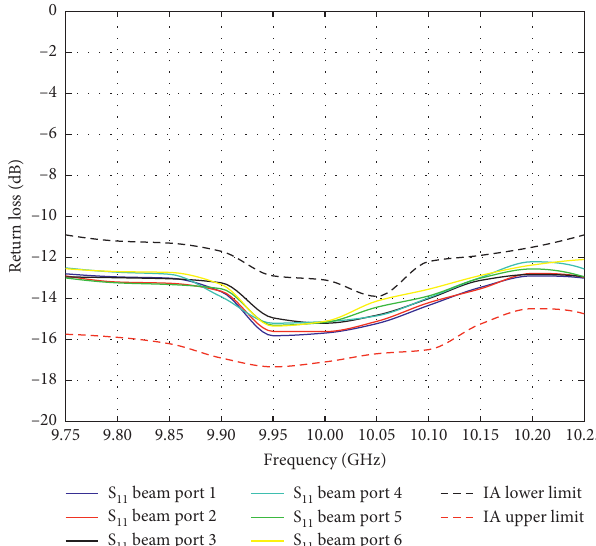
Figure 25: Insertion loss measured at the beam